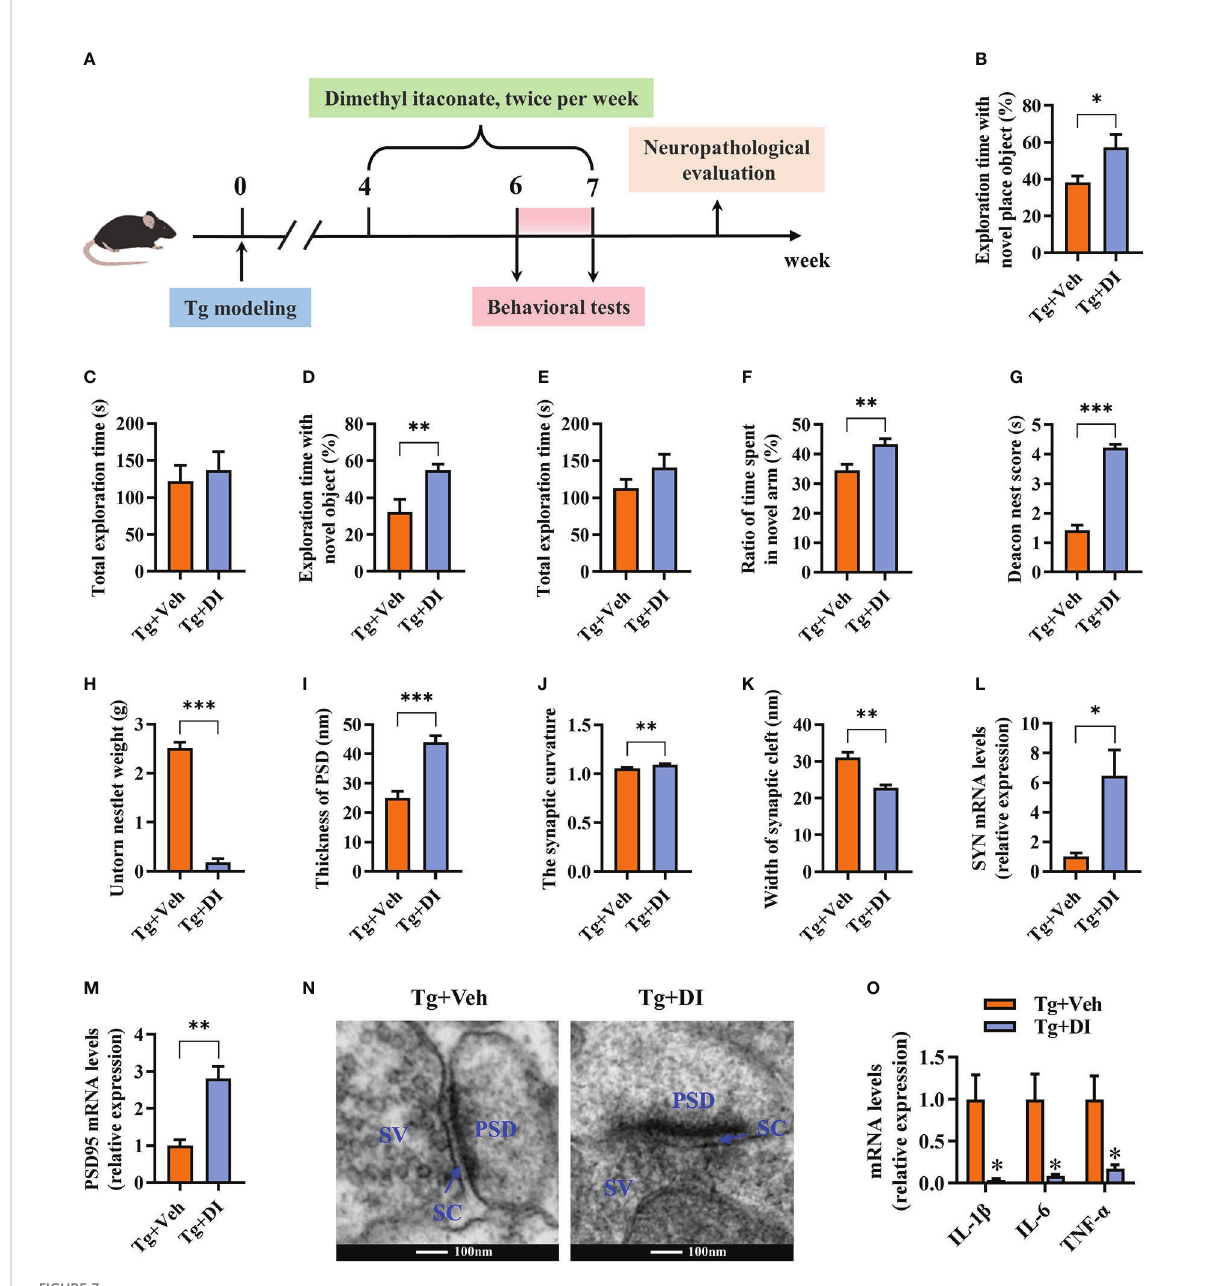
FIGURE 7 Dimethyl itaconate has the therapeutic effect on T. gondii -induced cognitive and synaptic impairments in mice. (A) Schematic timeline for DI therapeutic effect on cognitive de fi cits induced by T. gondii infection in mice. (B) Percentage of time spent with the object in the novel place to total object exploration time and (C) the total object exploration time in the novel location test were recorded. (D) Percentage of time spent with the novel object to total object exploration time and (E) the total object exploration time in the novel object recognition test were recorded. (F) Percentage of time spent with the novel arm to total arm exploration time in Y-maze spatial memory test. (G) The nest score and (H) untorn nestlet weight (amount of untorn nesting material) ( n = 10 mice for each group). (I – K) Image analysis of the thickness of postsynaptic density (PSD), the synaptic curvature, and width of the synaptic cleft (SC) ( n = 2, 10 images per mouse). (L, M) The mRNA expression of SYN and PSD95 in the hippocampus ( n = 3). (N) The ultrastructure of synapses in the hippocampus CA1 region of mice in Tg+Veh group compared with Tg+DI group on the electron micrograph (scale bar 100 nm). (O) The mRNA expression of IL-1 b , IL-6 and TNF- a in the hippocampus ( n = 3). Tg+Veh, T. gondii infected mice with vehicle control treatment; Tg+DI: T. gondii infected mice with DI treatment. Values are mean ± SEM. * P <0.05, ** P <0.01, *** P